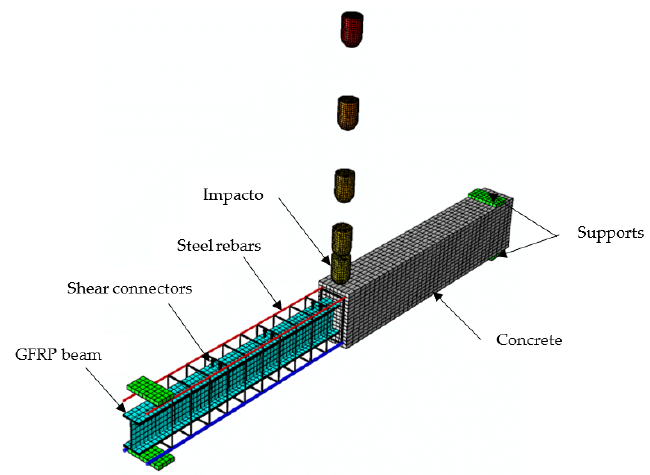
Figure 17. FE mesh of the composite specimen CGC ‐ I for impact analysis.